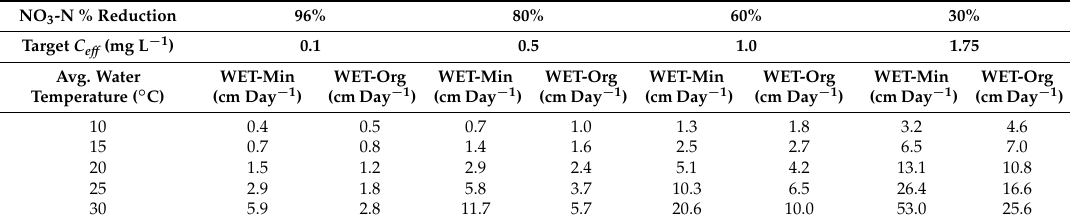
Table 5. Predicted maximum hydrologic loading capacities for the future restored wetlands assuming n of 0.95, and C in of 2.5 mg L − 1 using the first order decay kinetic model. NO 3 -N %